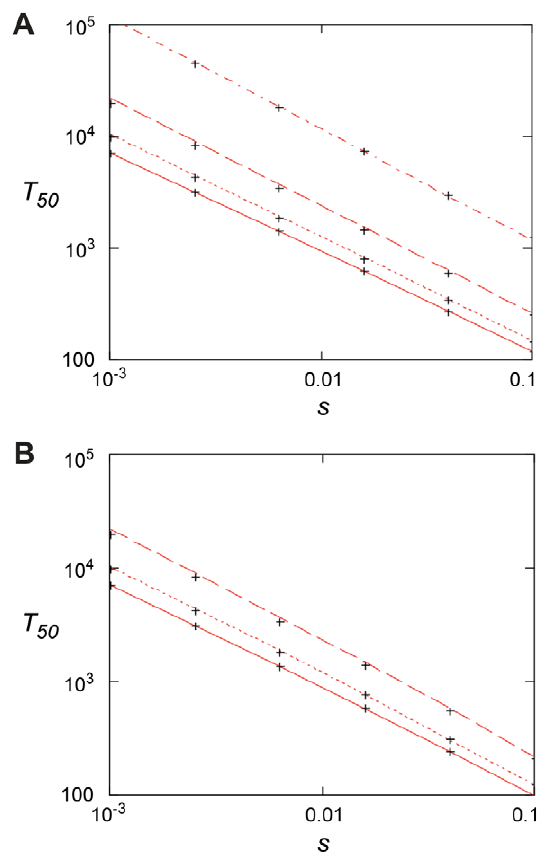
Figure 6. Fixation time for adaptive mutations. (A) 50% penetration time as function of selection coefficient when no mutants are present initially for N =10 7 and, from top to bottom, u =10 2 9 , 10 2 8 , 10 2 7 , and 10 2 6 . Red lines are from Eq. (4) and the crosses from the stochastic model, Eqs. (7) – (10), with m 0 =0. (B). 50% penetration time as function of the selection coefficient when the initial presence of mutants is determined by mutation-selection balance, m 0 = Nf 0 = uN /| s 0 |. Results arefor s 0 = 2 0.02, N =10 7 and, fromtop tobottom, u =10 2 6 , 10 2 7 , 10 2 8 . The red lines are from Eq. (6), and the crosses are from the stochastic model, Eqs. (7) –